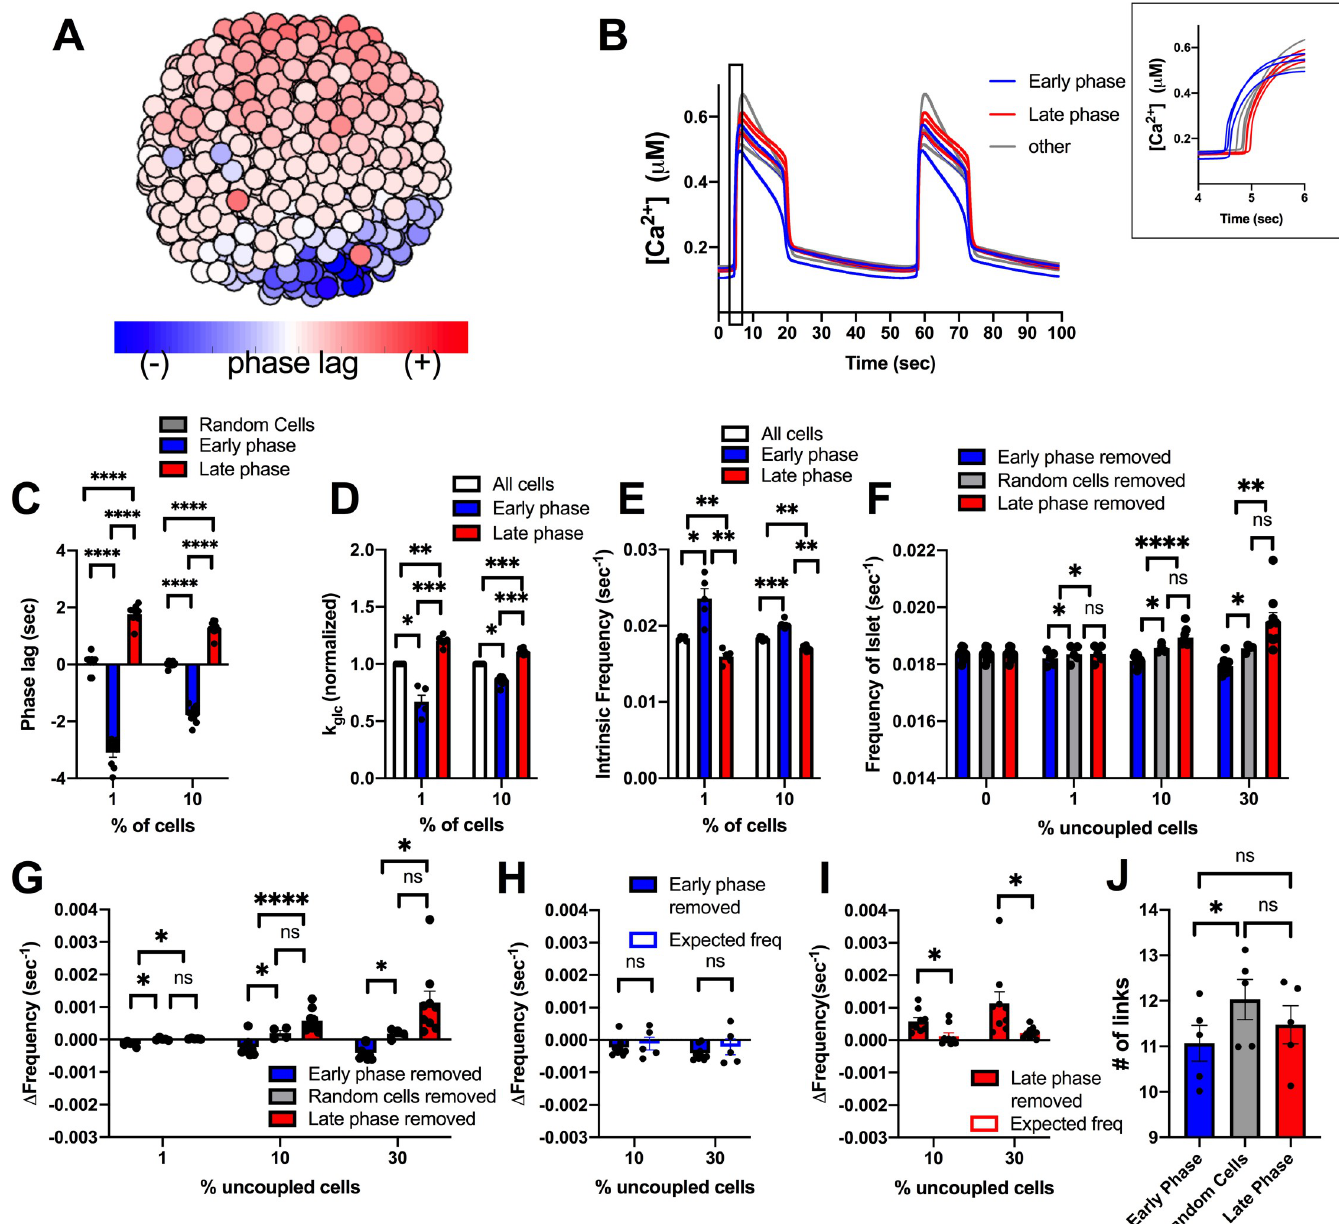
Fig 4. Simulations predicting how small populations of cells contribute to islet frequency. A). Schematic of phase lag across simulated islet with 25% variation in GK activity. B). Representative time courses of [Ca 2+ ] for 9 cells in simulated islet at 60pS coupling conductance to determine phase lag of cells in A. Blue traces are early phase cells (negative phase lag), Grey is non early or late phase cells, red is late phase cells (positive phase lag). Inset: Close up of rise of [Ca2+] oscillation showing phase lags. C). Phase lag from islet average of top 1% or 10% of early phase, late phase cells, or random cells. D). Average k glc from all cells, early phase cells or late phase cells across simulated islet (normalized to average k glc ). E). Average intrinsic oscillation frequencies of all cells, top 1% and 10% of early phase cells, or top 1% or 10% of late phase cells when re-simulated in the absence of gap junction coupling (0pS). F). Average frequency of islet when indicated populations of cells are removed from the simulated islet. G). Change in frequency of islet with indicated populations removed with respect to control islet with all cells present. H). Change in frequency when early phase cells are removed compared to average oscillation frequency of remaining cells that indicates the expected oscillation frequency. I). Same as H. but